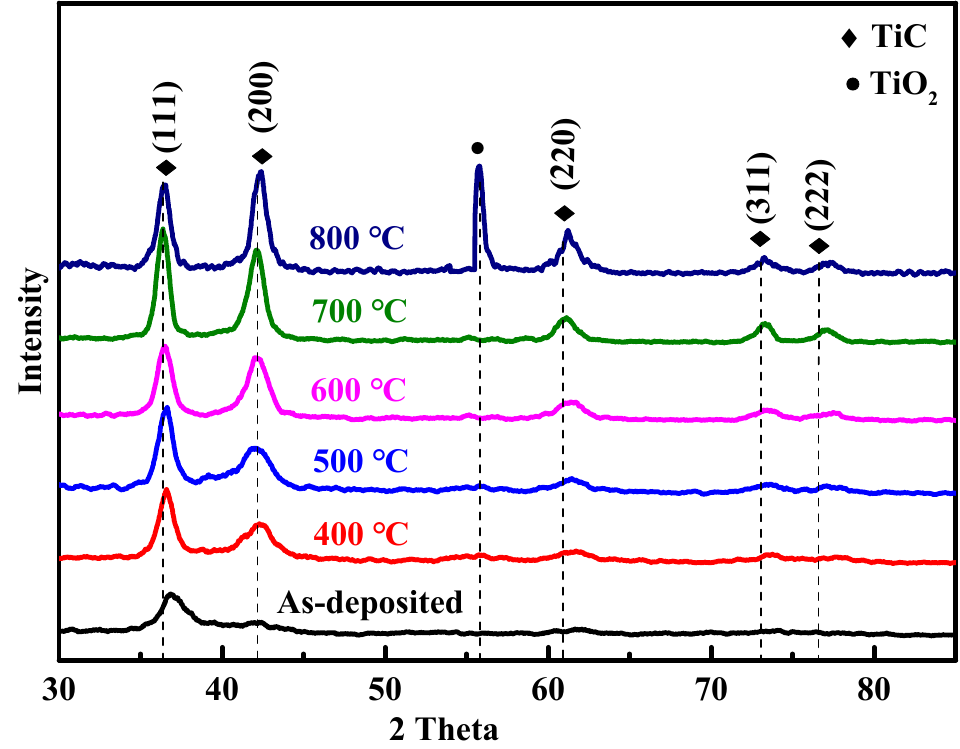
Figure 1. GIXRD patterns of as-deposited and annealed TiC thin films with a thickness of 610 nm.